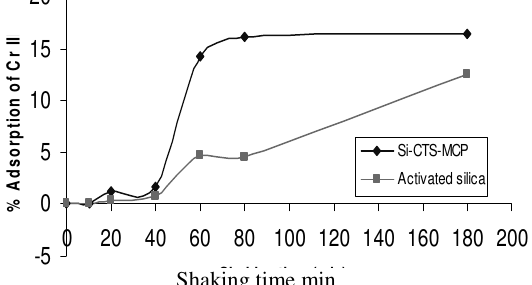
Figure 10. Effect of the interaction time on the percentage adsorption of chromium(III) onto Si-CTS-MCP and activated